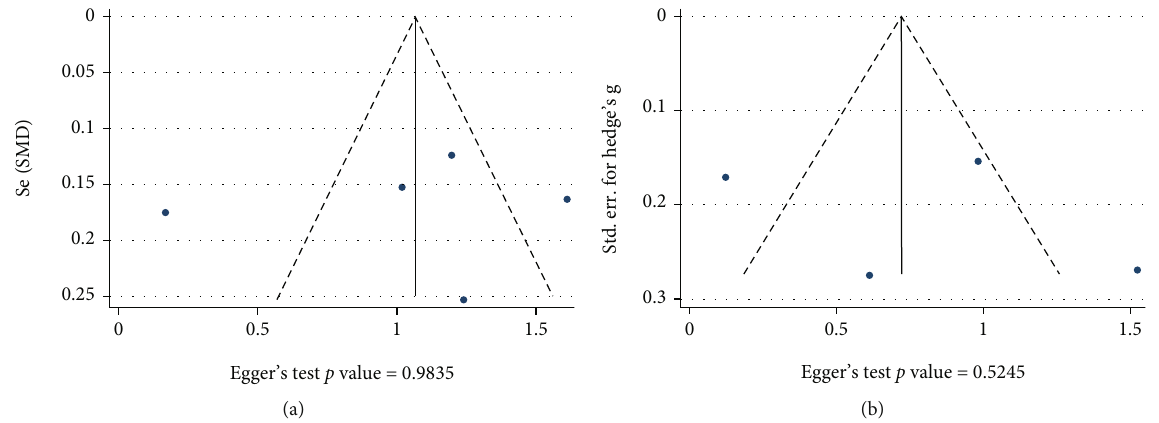
Figure 14: Publication bias between studies on (a) di ff erences in NLR levels between GBS cases and controls and (b) di ff erences between pre- and posttreatment NLR levels in GBS